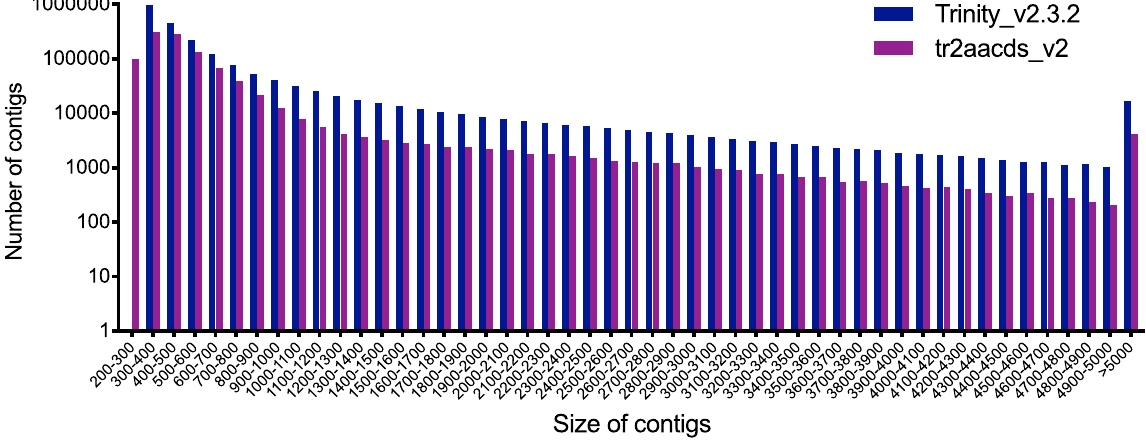
Figure 8. Comparison of contig size and number for Trinity_v2.3.2 (moderate filtering of poor quality read pairs) and tr2aacds_v2 (including v2.3.2 Trinity output)